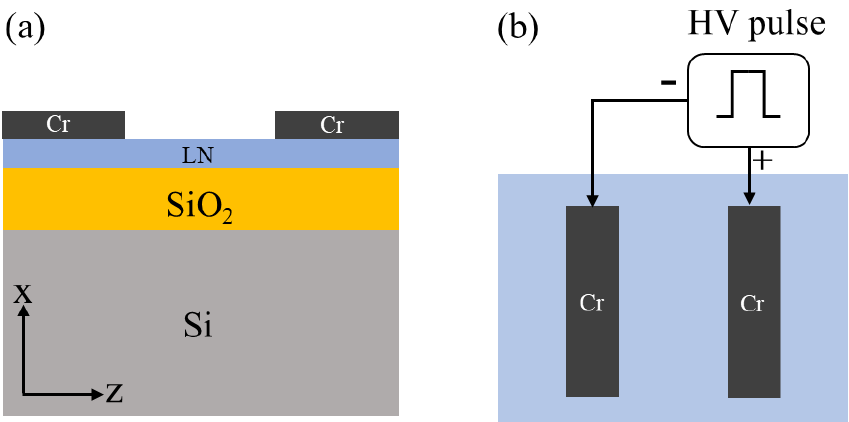
Figure 3. Cross section of Cr on x-cut LNOI ( a ) and scheme of domain polarization inversion configuration ( b ).